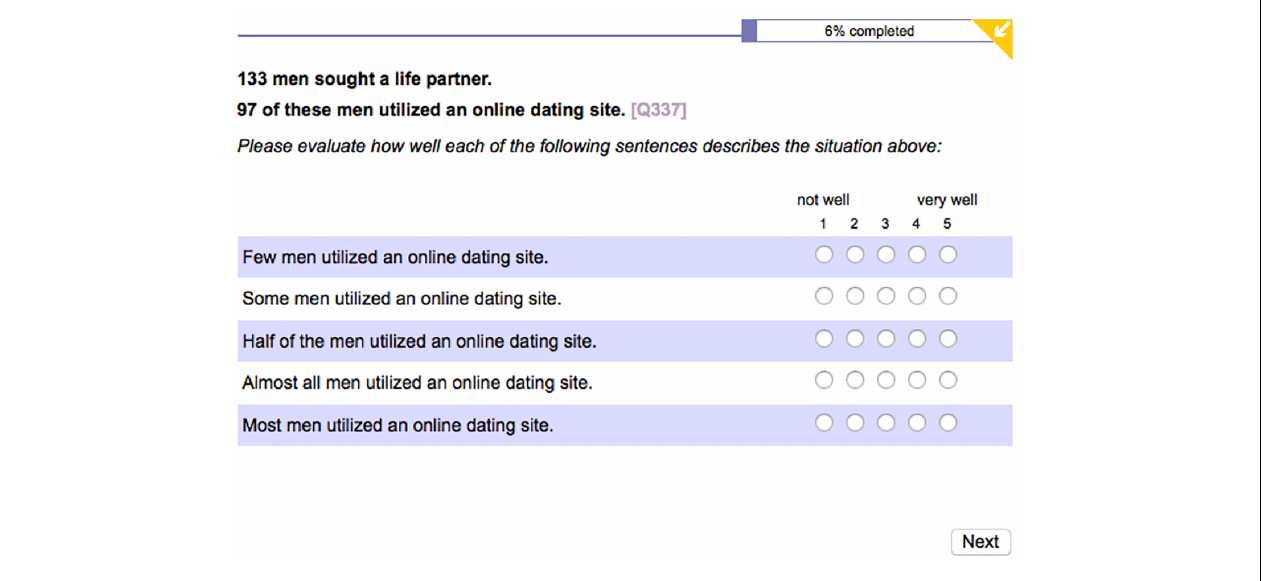
FIGURE 1 | Experiment 1: A sample stimulus screen (the English